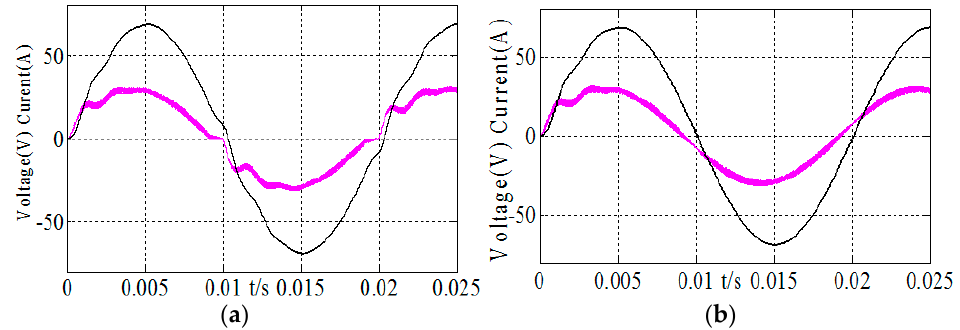
Figure 12. The grid voltage and inductor current of H5. θ = 30 ◦ , 5 times attenuation of voltage. ( a ) Modulation I. ( b ) Hybrid modulation mode (HMM).